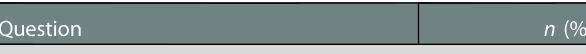
TABLE 2 Satisfaction survey